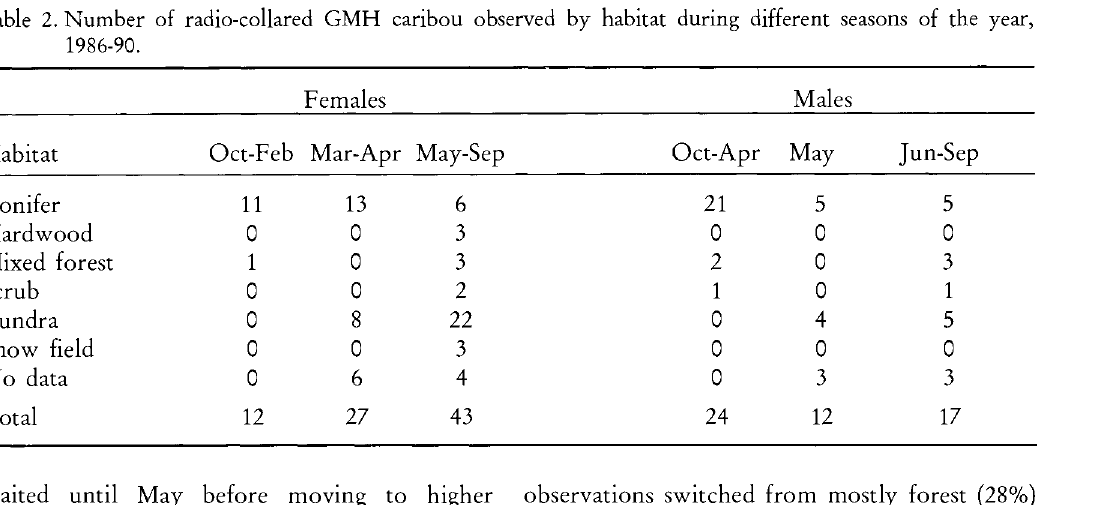
Table 2. Number of radio-collared G MH caribou observed by habitat during different seasons of the year, 1986-90. Females Males Habitat Oct-Feb Mar-Apr